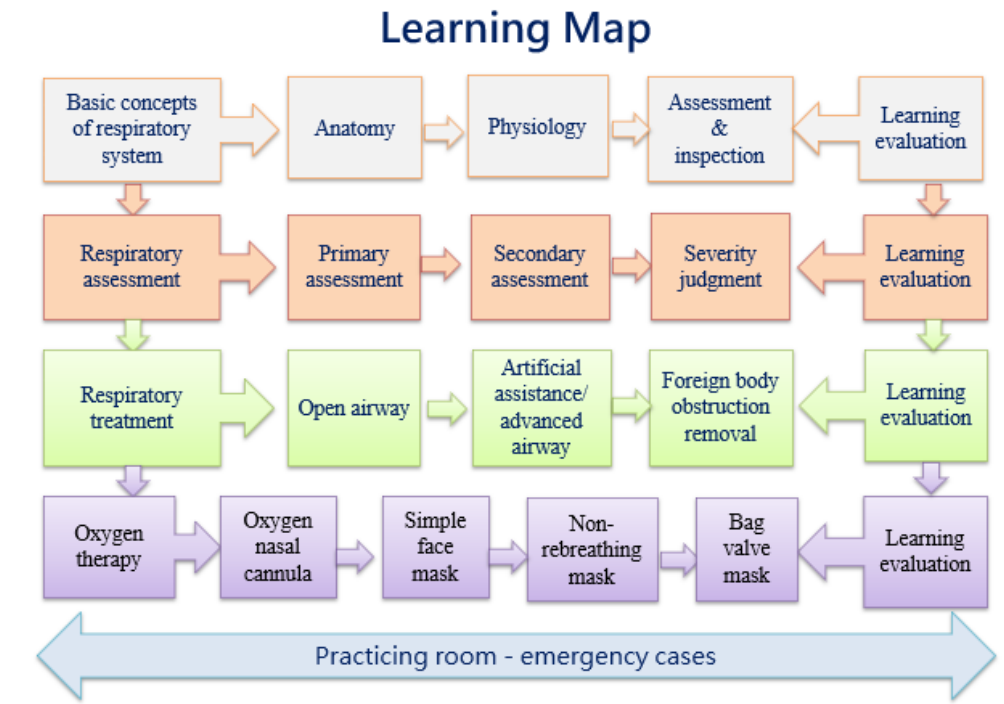
Figure 1. Learning map interface of the interactive eBook.